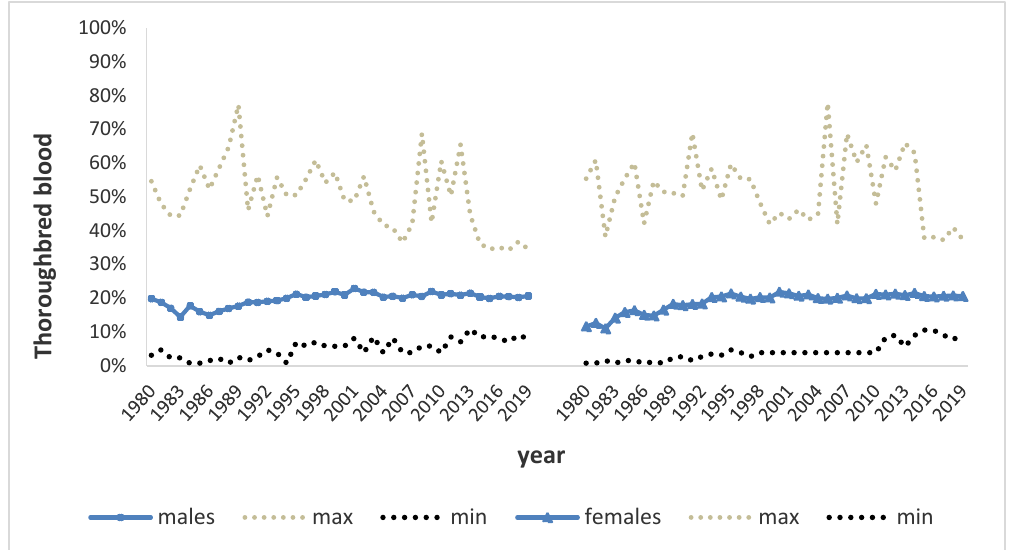
Figure 2. Maximum, minimum, average Thoroughbred blood percentage in the whole Maremmano population per year of birth from 1980 to 2019.